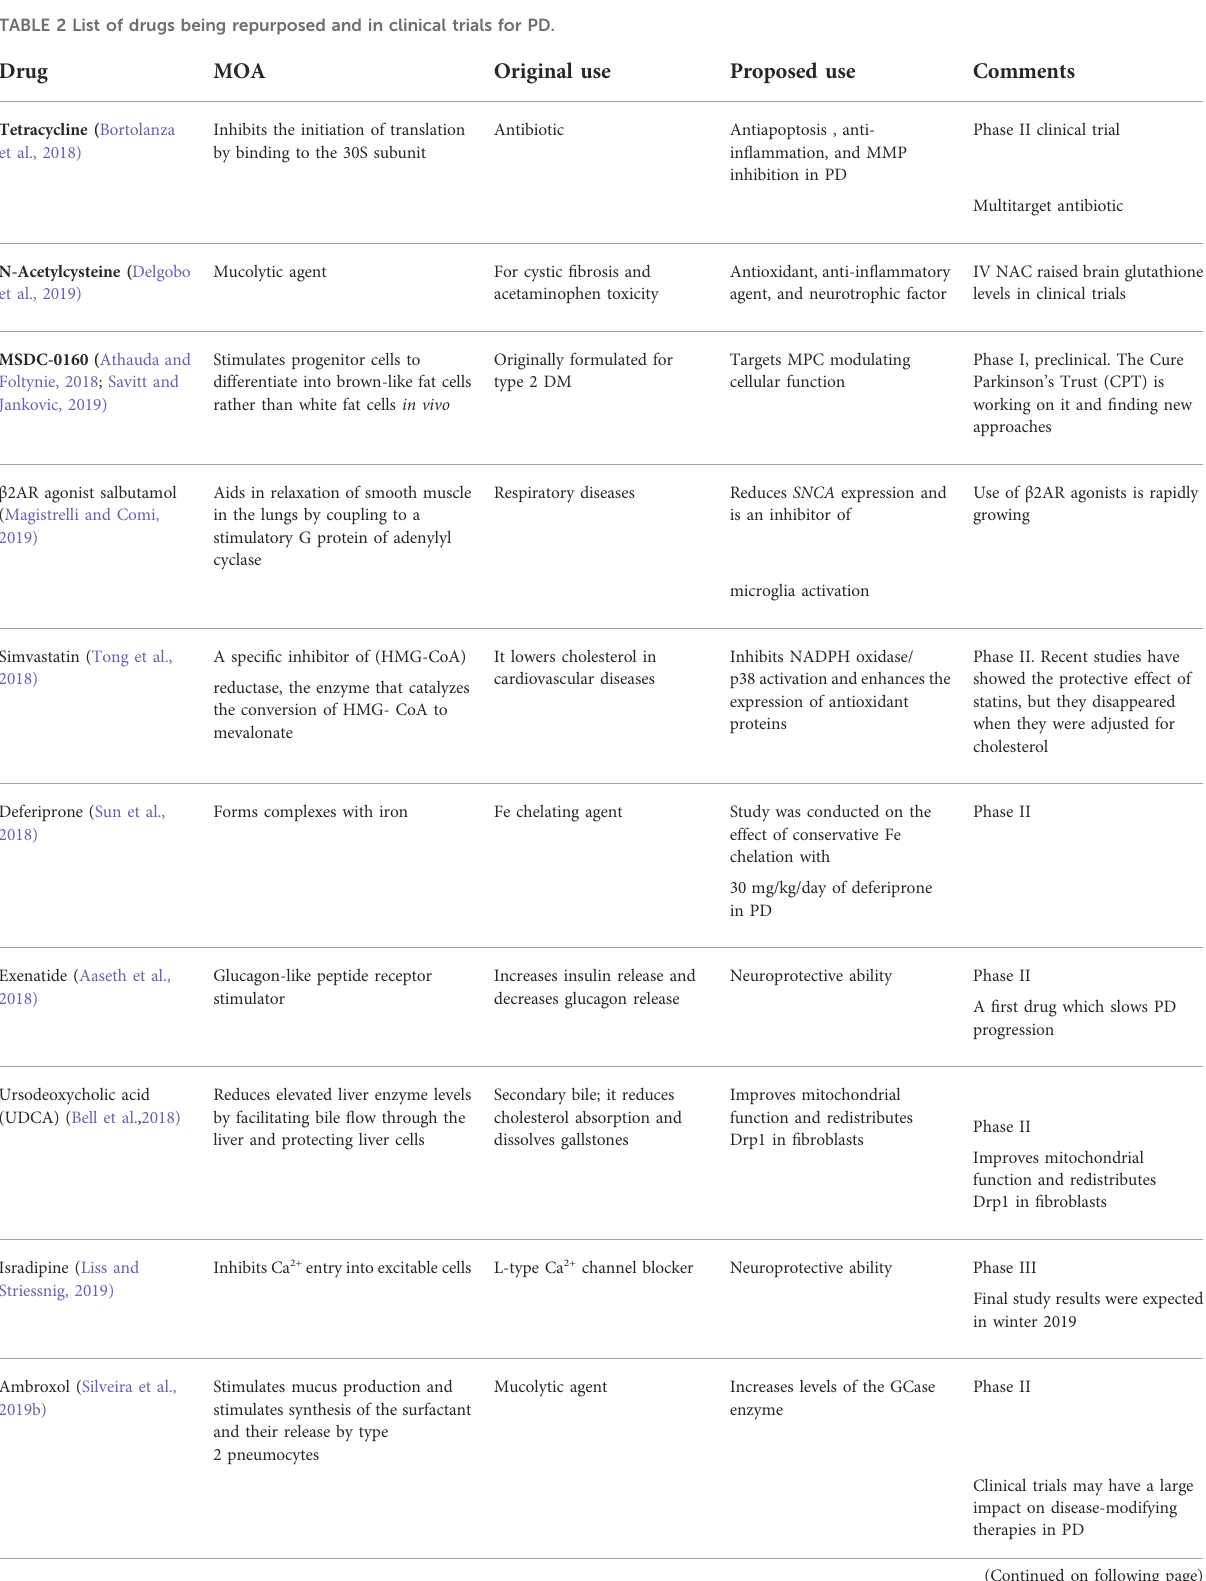
TABLE 2 List of drugs being repurposed and in clinical trials for